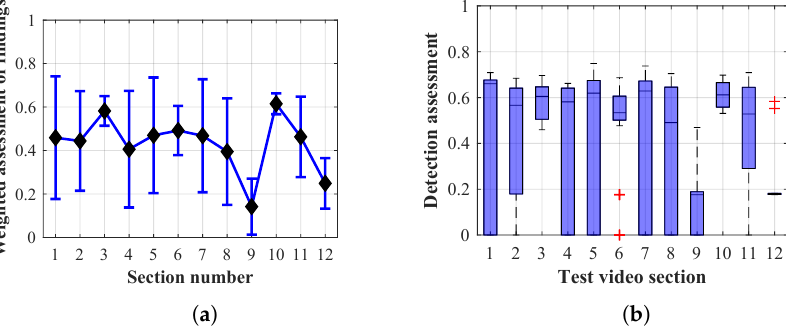
Figure 39. Results of Method 2.2 with a lifespan of 1 frames. ( a ) the weighted average rating with the average mean absolute error of the weighted rating and ( b ) boxplots of the distribution of the statistical sets of the results of the individual sections evaluated indicating: minimum, 1st quartile, median, 3rd quartile,